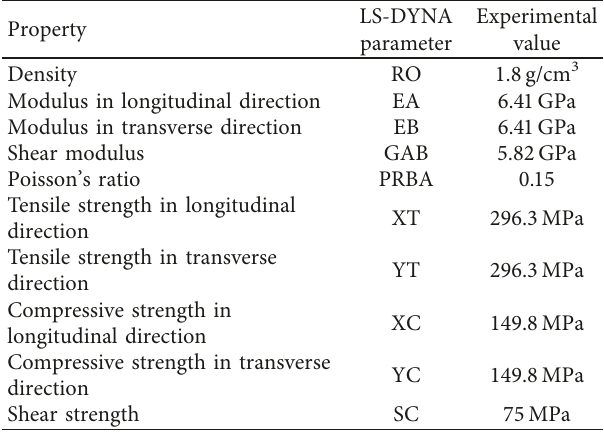
Table 4: Material parameters of GFRP lattice